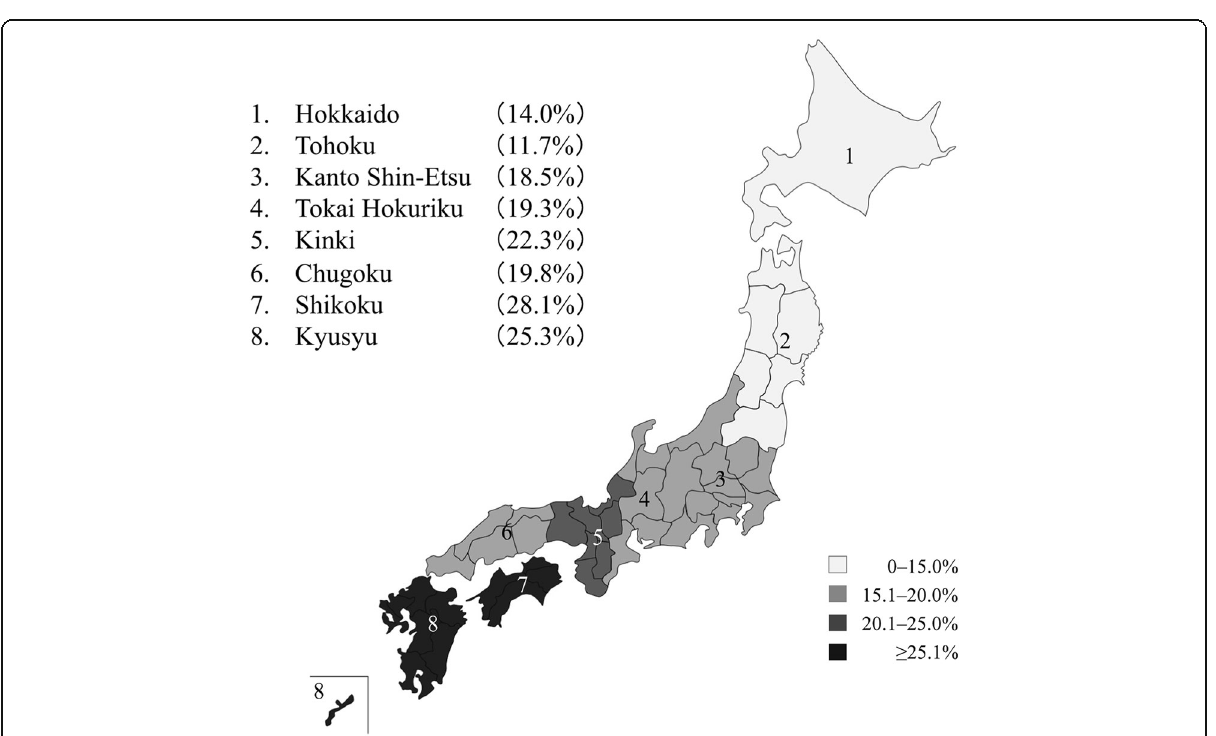
Fig. 3 MIH prevalence rates throughout Japan. MIH exhibited low prevalence in northeastern areas and high prevalence in southwestern areas of